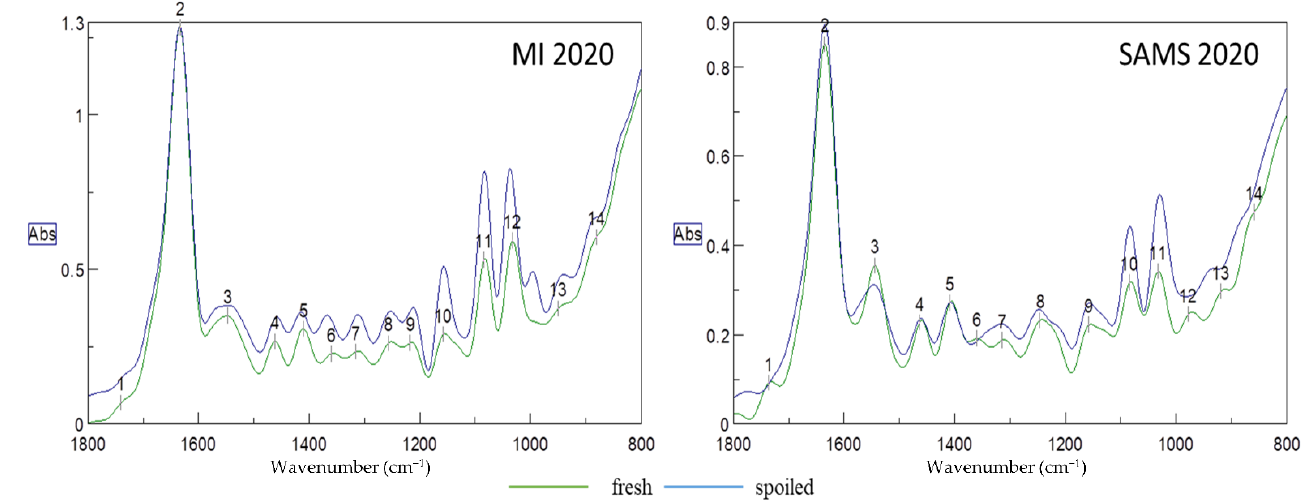
Figure 1. Representative deconvoluted FT-IR spectra of fresh and spoiled seaweed of different aquaculture sites harvested in 2020.